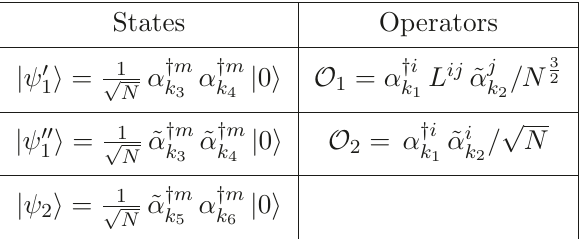
Table 1 . States and operators used in demonstrating the N -scaling